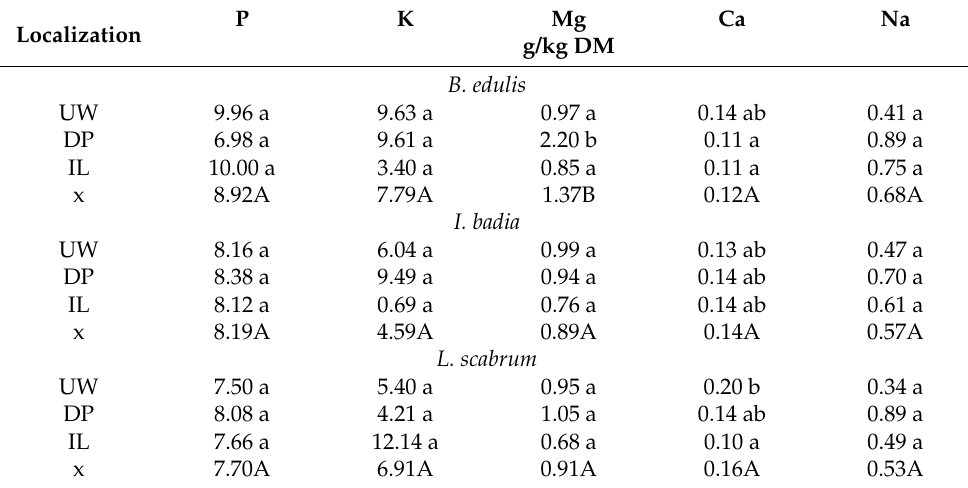
Table 3. The content of macronutrients in fungi.